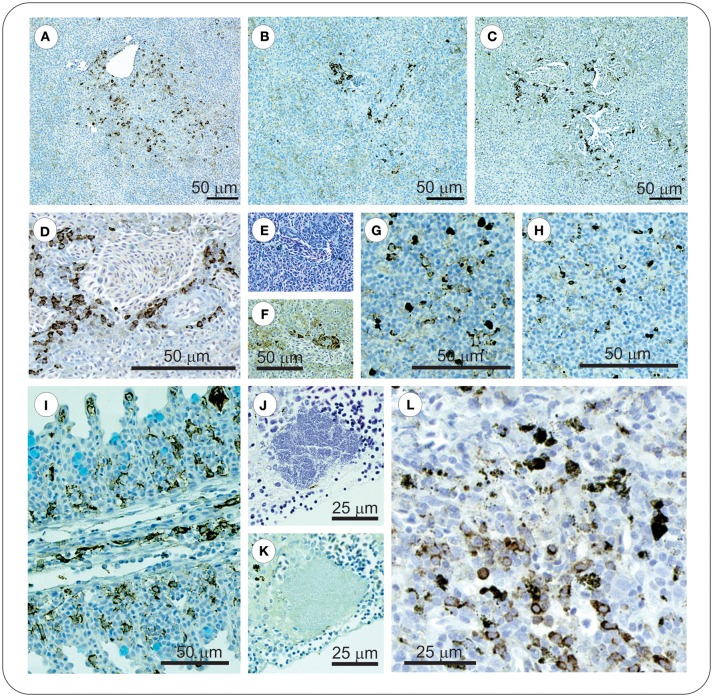
At 8 dpi positive IgM+ immunolabelled cells in spleen of vaccinated charr were often observed as clusters around melanomacrophage centers (MMCs) (A–C), or ellipsoids (D–F). In contrast, at 29 dpi, clusters of these cells were no longer evident, and instead were scattered through the spleen (G–H). ForteMicro®-vaccinated charr gill was densely populated with IgM+ cells at 8 dpi (I). In kidney of PBS-injected controls, Asal colonies were not associated with IgM+ lymphocytes (J,K), however positive immunolabeled cells were observed associated with melanomacrophages (L).